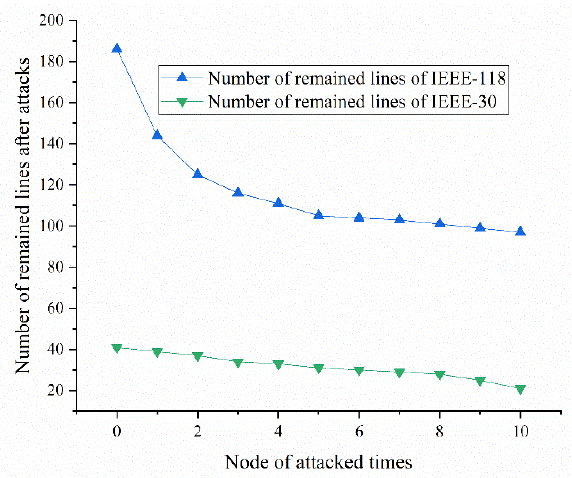
Figure 28. Cascading failures as attacks